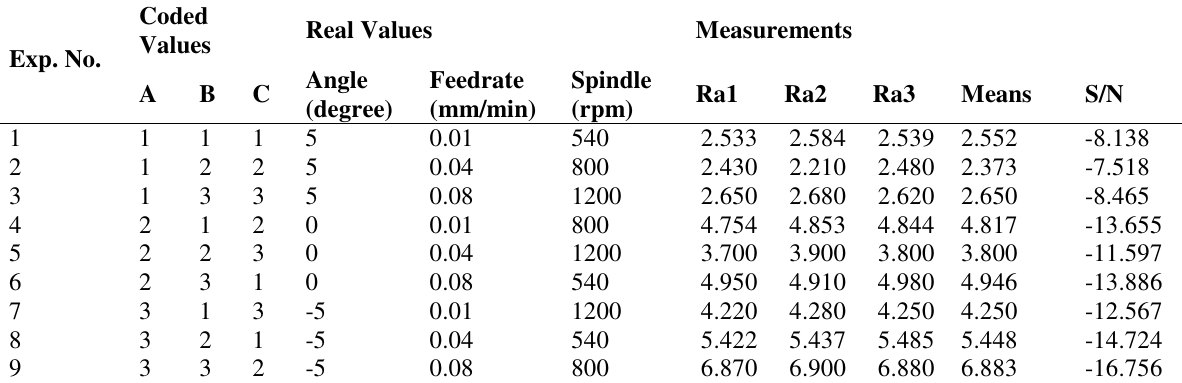
Results for brass.